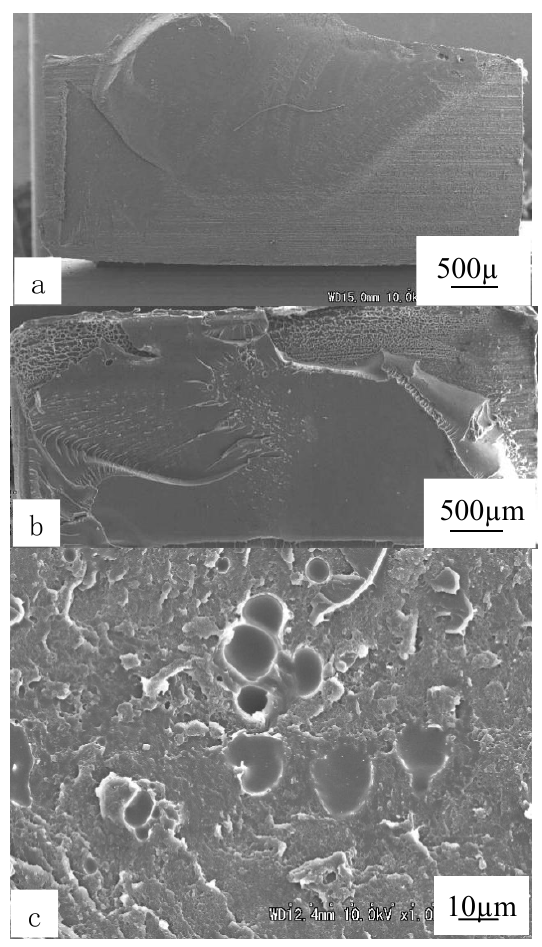
Figure 11. SEM images of ruptured surfaces of welded interfaces of PC side under welding pressure of 0.3MPa. ( a ), ( b ), ( c ) are under welding time of 1.5 s, 3 s and 4 s. Adapted from Reference [149].